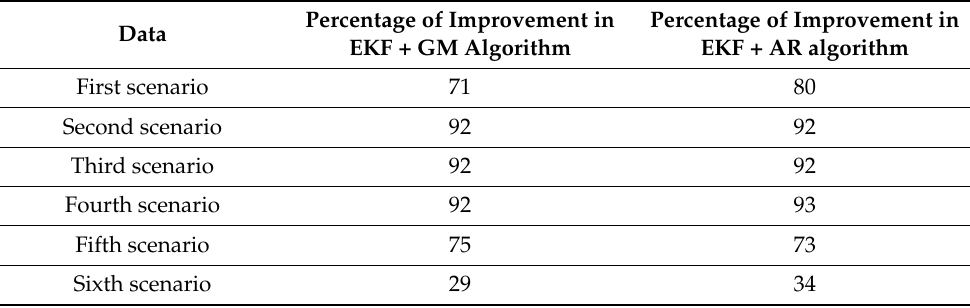
Table 2. The percentage of improvement in the positioning accuracy of the EKF algorithm using proposed VCM.